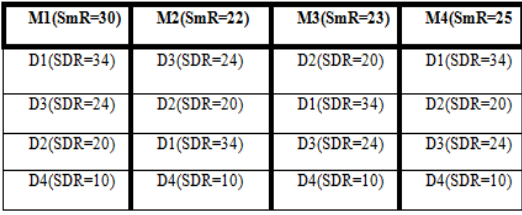
TABLE I. R ESULTS OF VARIOUS SEARCH ENGINES